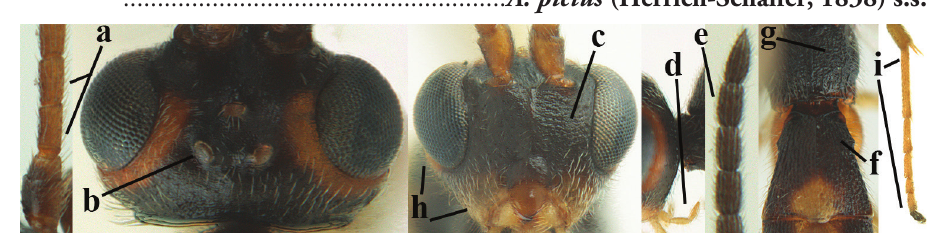
Third and fourth antennal segments of ♀ slenderer (a); ocelli smaller (b); rugosity of face of female less developed (c); palpi slenderer (d); subapical antennal segments of ♀ moderately slender (e); first tergite slenderer (f); pro- podeum mainly coriaceous and with some rugulae or rugae (g); malar space usually partly or completely and temple near eye yellowish brown (h); fore and hind tarsi slenderer (hind tarsus: i); fore wing subhyaline or somewhat infuscate; mummy slender and light brownish